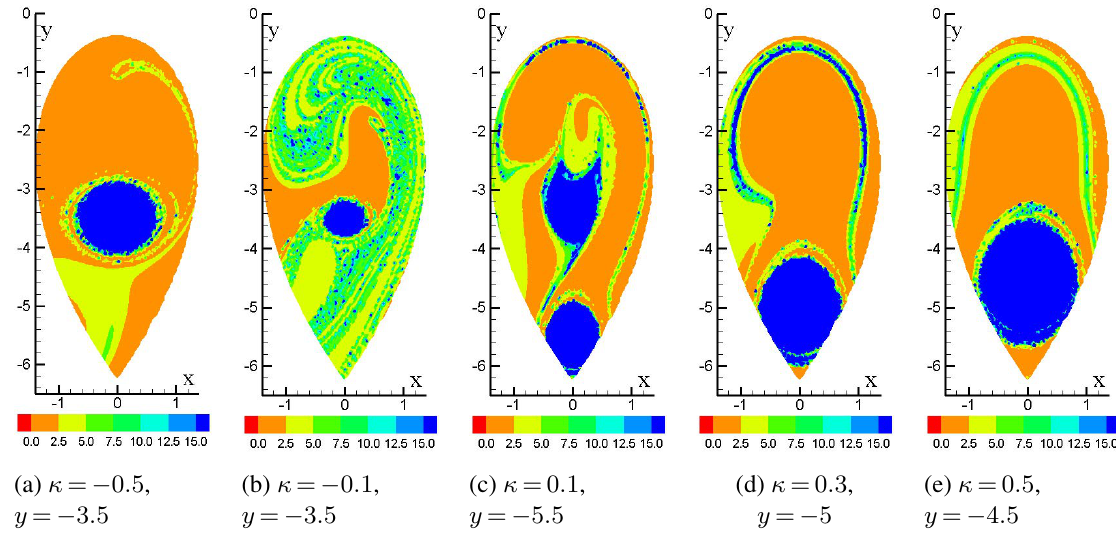
Fig. 8. Escape-time distribution in the upper-layer monopole case. Fig. 8: Escape time distribution in the upper-layer monopole case. Fig. 8: Escape time distribution in the upper-layer monopole case.